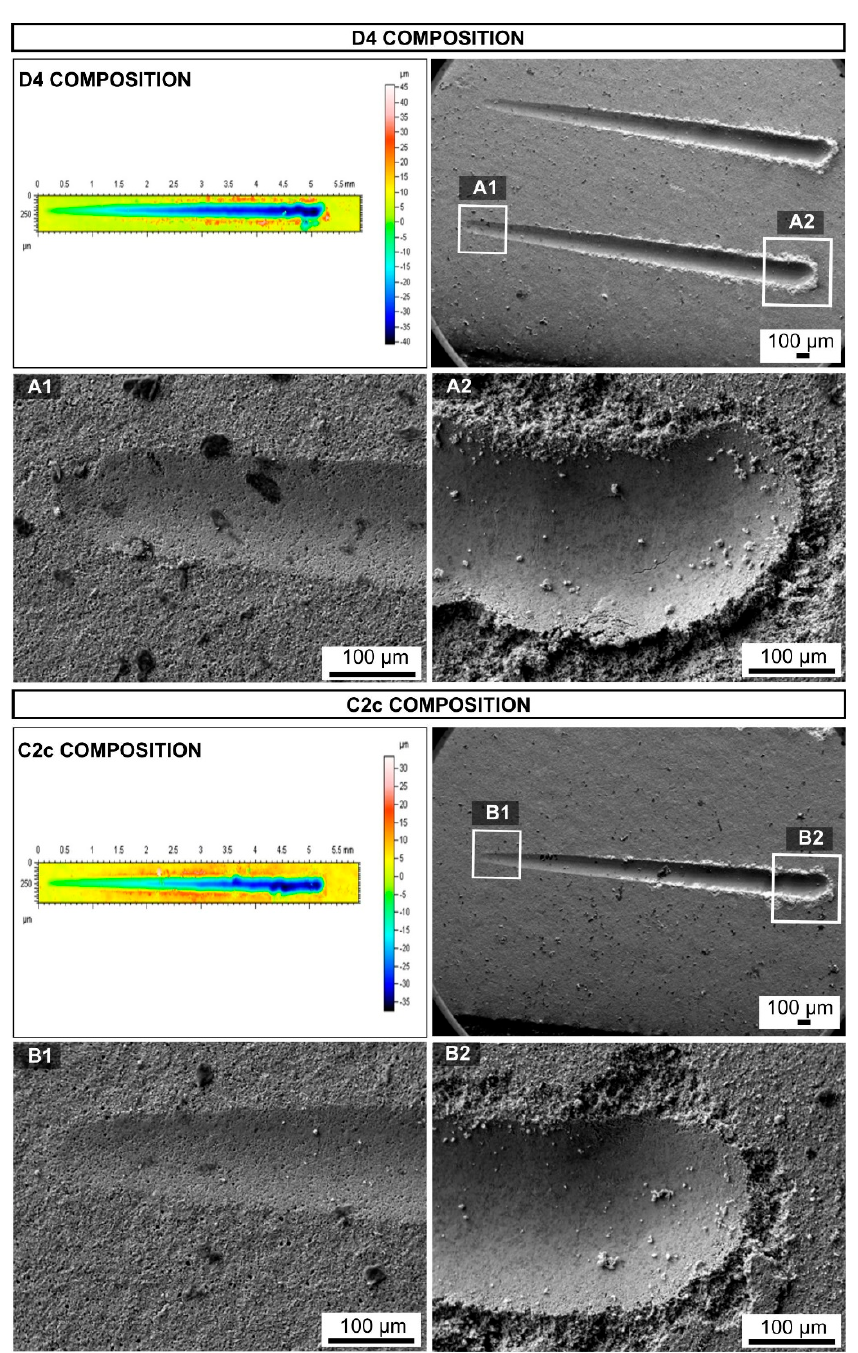
Figure 3. Scratch morphology in the coatings C2c and D4 after pyrolysis in ambient air at 850 °C/1h.